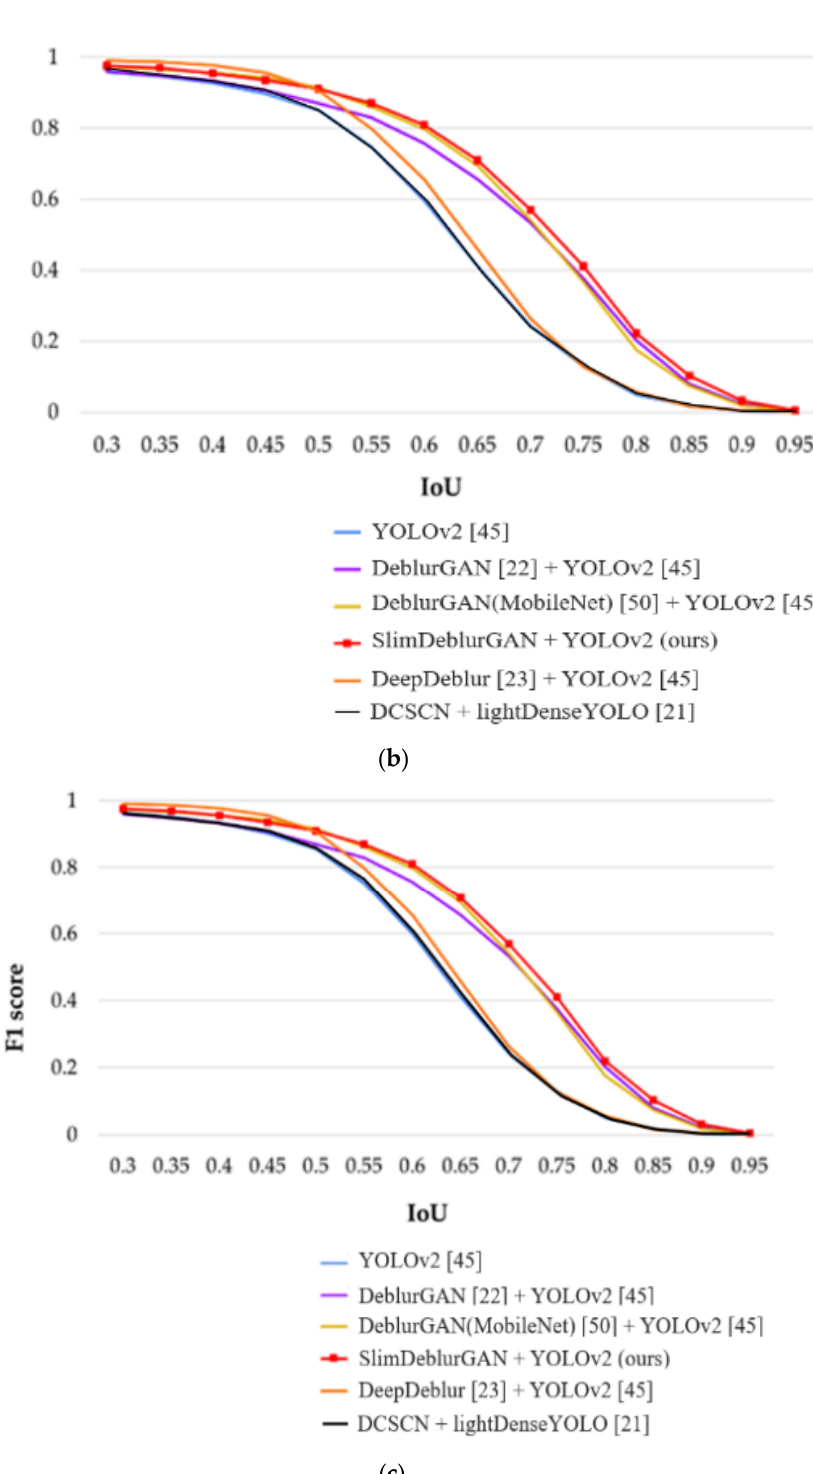
Figure 16. Examples of detection results on RMBD-DB1. The green boxes represent the ground truth bounding boxes and the red boxes represent the boxes detected by ( a ) YOLOv2, ( b ) DeepDeblur and YOLOv2, ( c ) a combination of DeblurGAN and YOLOv2, ( d ) a combination of DeblurGAN (MobileNet) and YOLOv2, and ( e ) a combination of SlimDeblurGAN and YOLOv2 (ours). 4.3.3. Comparisons on Processing Speed and Discussion We measured the processing speed of our method on both an embedded system and a desktop computer. The specifications of the desktop computer are explained in Section 4.2, and a Jetson TX2 system was used as the embedded system, as shown in Figure 17. A Jetson TX2 embedded system is a fast, power-efficient device optimized for artificial intelligence (AI). It includes an NVIDIA Pascal™-family GPU (256 CUDA cores) with 8 GB of memory and features various standard hardware interfaces that facilitate integration into a wide range of products like UAVs and autonomous vehicle [51]. As the board was pre-flashed with a Linux development environment, we installed the Ubuntu 16.04 operating system, which was a convenient environment for training and testing deep learning models, as recommended by NVIDIA. Our proposed SlimDeblurGAN and YOLOv2, including the comparative algorithms were implemented in desktop computer by TensorFlow 1.14 [52], CUDA ® toolkit (ver. 10.0) [53], and NVIDIA CUDA ® deep neural network library (CUDNN) (ver. 7.6.2) [54]. These were also implemented in the Jetson TX2 system by TensorFlow 1.12 [52], CUDA ® toolkit (ver. 9.0) [53], and NVIDIA CUDNN (ver. 7.3) [54]. The full specifications of the Jetson TX2 embedded system are presented in Table 15.